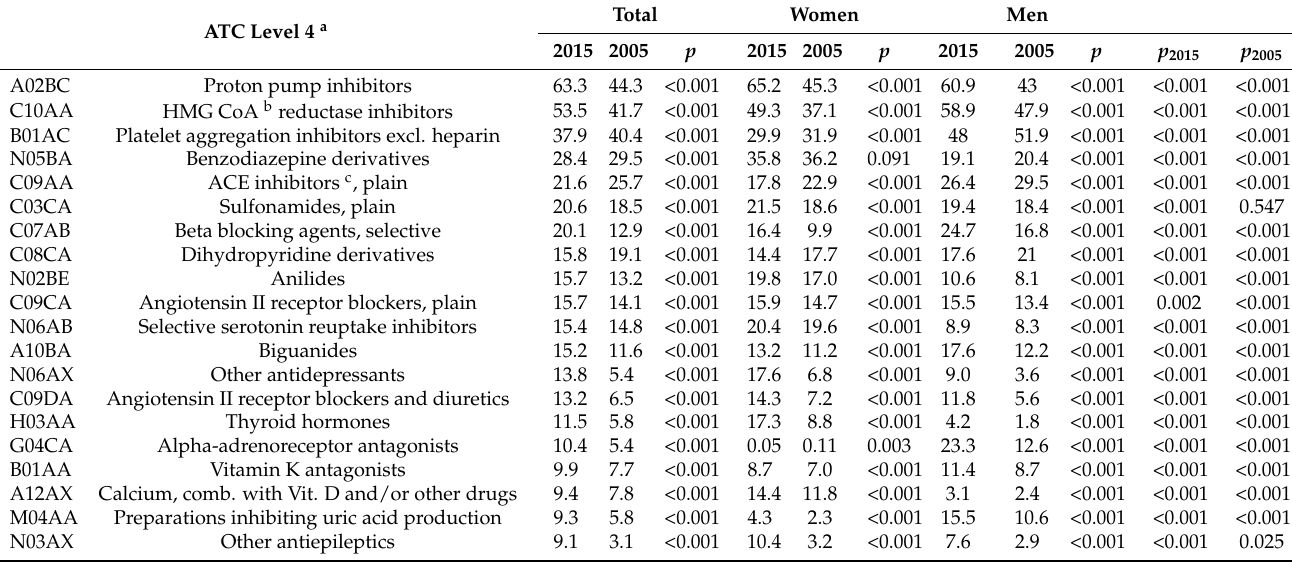
Table 1. Prevalence (%) of the 20 most frequently prescribed courses of treatment (ATC level 4) in patients with polypharmacy in 2015 in both sexes and their prevalence in